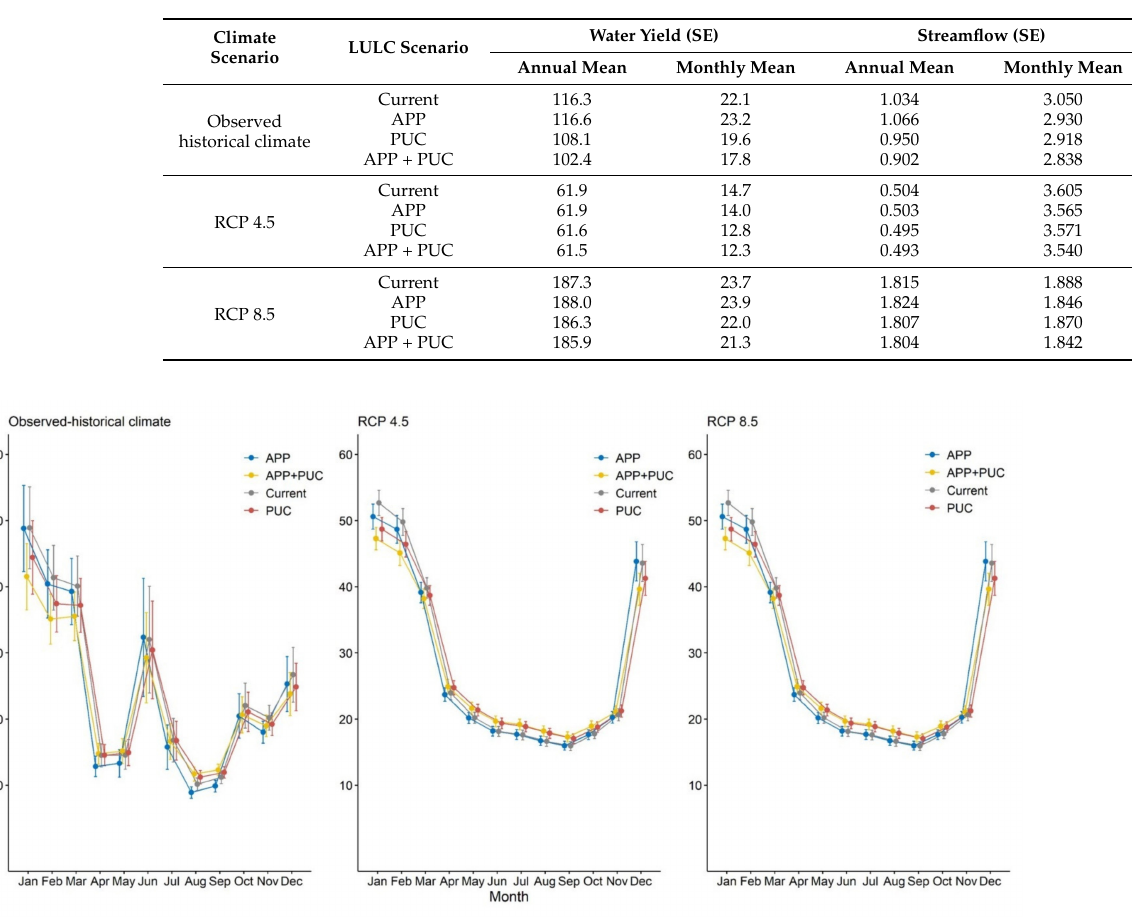
Figure 5. Monthly mean water yield for each LULC scenario (i.e., Current; APP = riparian restoration; PUC = focal conservation; APP + PUC = combined solution) in each climate condition for the entire simulation period: observed historical = average for each month of the year for the years 2012 to 2019; RCP 4.5 and RCP 8.5 = average for each month of the year for the years 2020 to